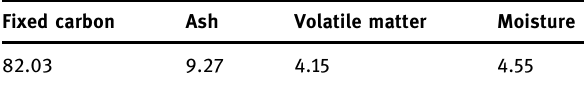
Table 1: The main chemical components of the phosphorus rock ( %wt )